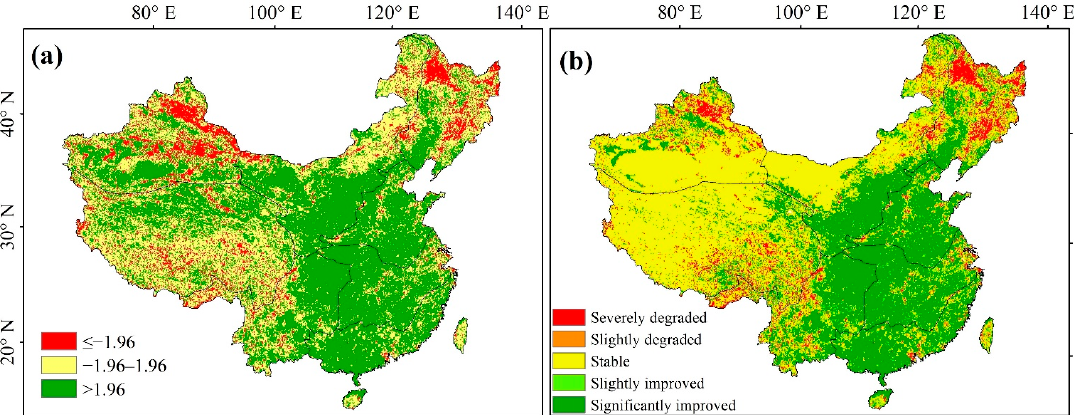
Figure 6. Spatial distribution of ( a ) M–K trend tests and ( b ) variation trend of the interannual NDVI in China from 1982–2018.